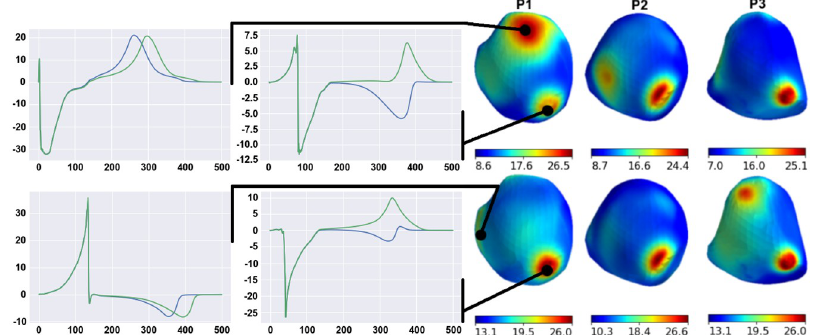
Fig 9. Examples of regional RED maps for the extracellular potential under variation of the apicobasal heterogeneity coefficient. The figure design is the same as in Fig 8.